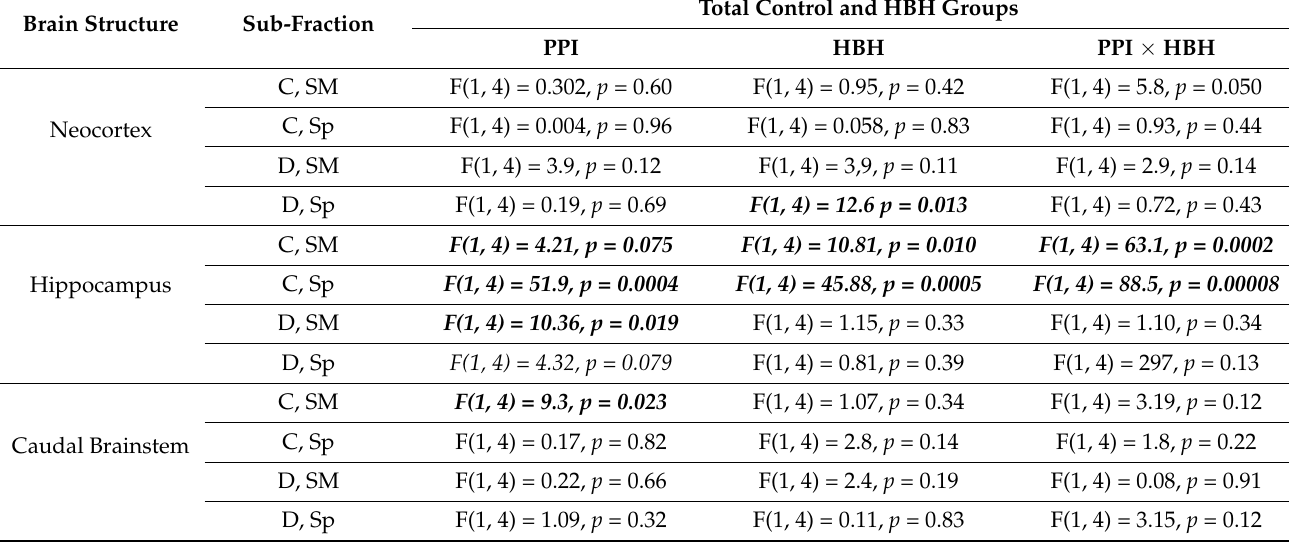
Table 1. The effects of PPI, HBH and PPI × HBH interaction on ChAT activity in different brain structures, neuron types and sub-fractions (ANOVA